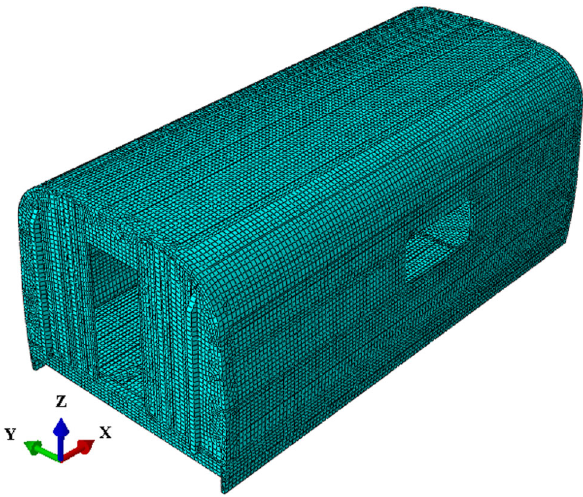
Fig. 2 Finite element model of vehicle